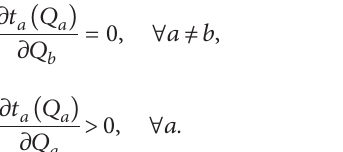
Figure 1: HBEFA emission factors for CO and NO